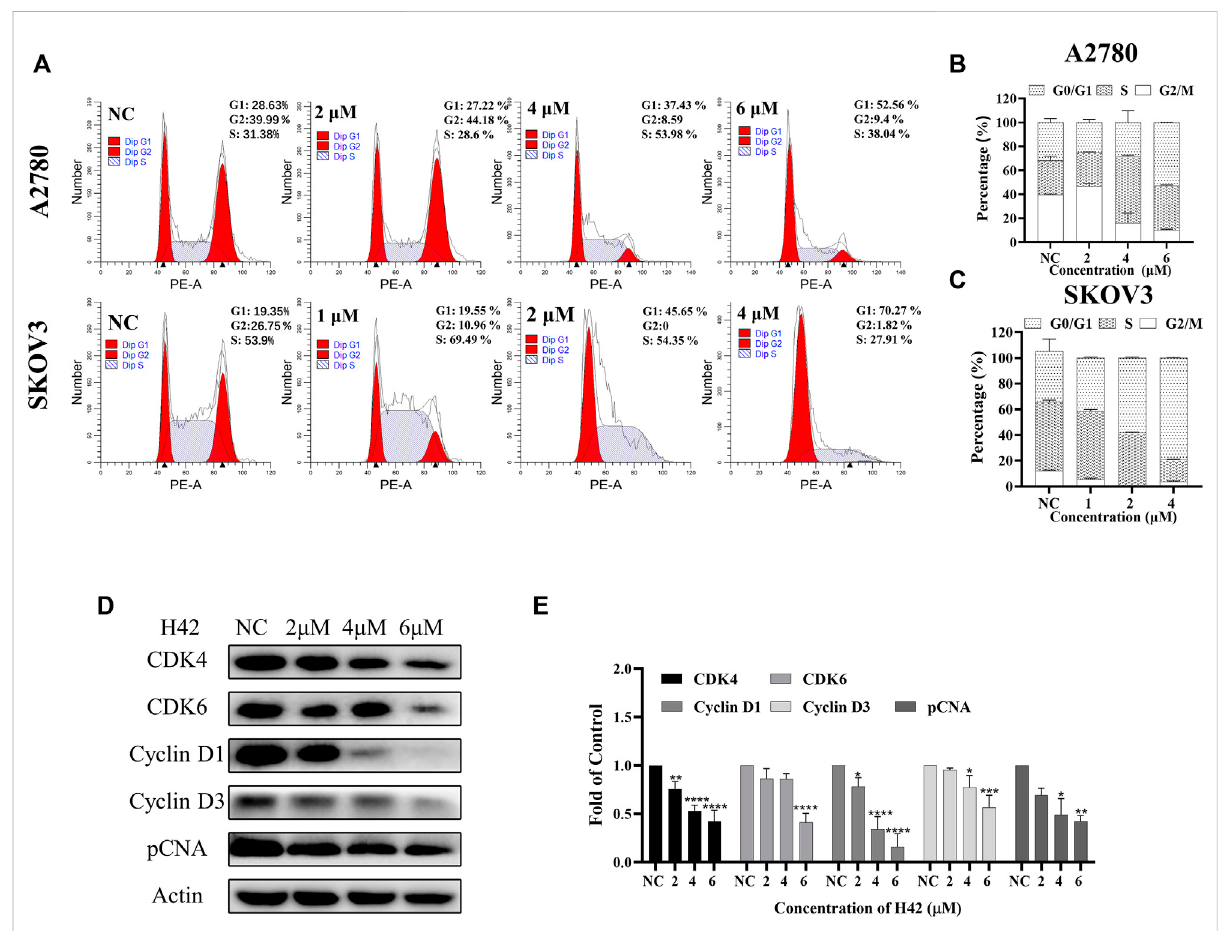
Compound H42 triggered G0/G1 cell cycle arrest in ovarian cancer cells. A2780 and SKOV3 cells were treated with various concentrations of H42 for 24H. (A) Cell cycledistributions weredetermined by PIstaining usingFCM.The quanti fi cationof A2780 andSKOV3 cell cycle distributions is presented in (B,C) . (D) Expression of cell cycle-related proteins in A2780 cells was examined by Western blot and (E) analyzed in the density ratio. Data are all represented as mean ± SD of at least three independent experiments. * p < 0.05, ** p < 0.01, *** p < 0.001, and **** p < 0.0001 were compared with the